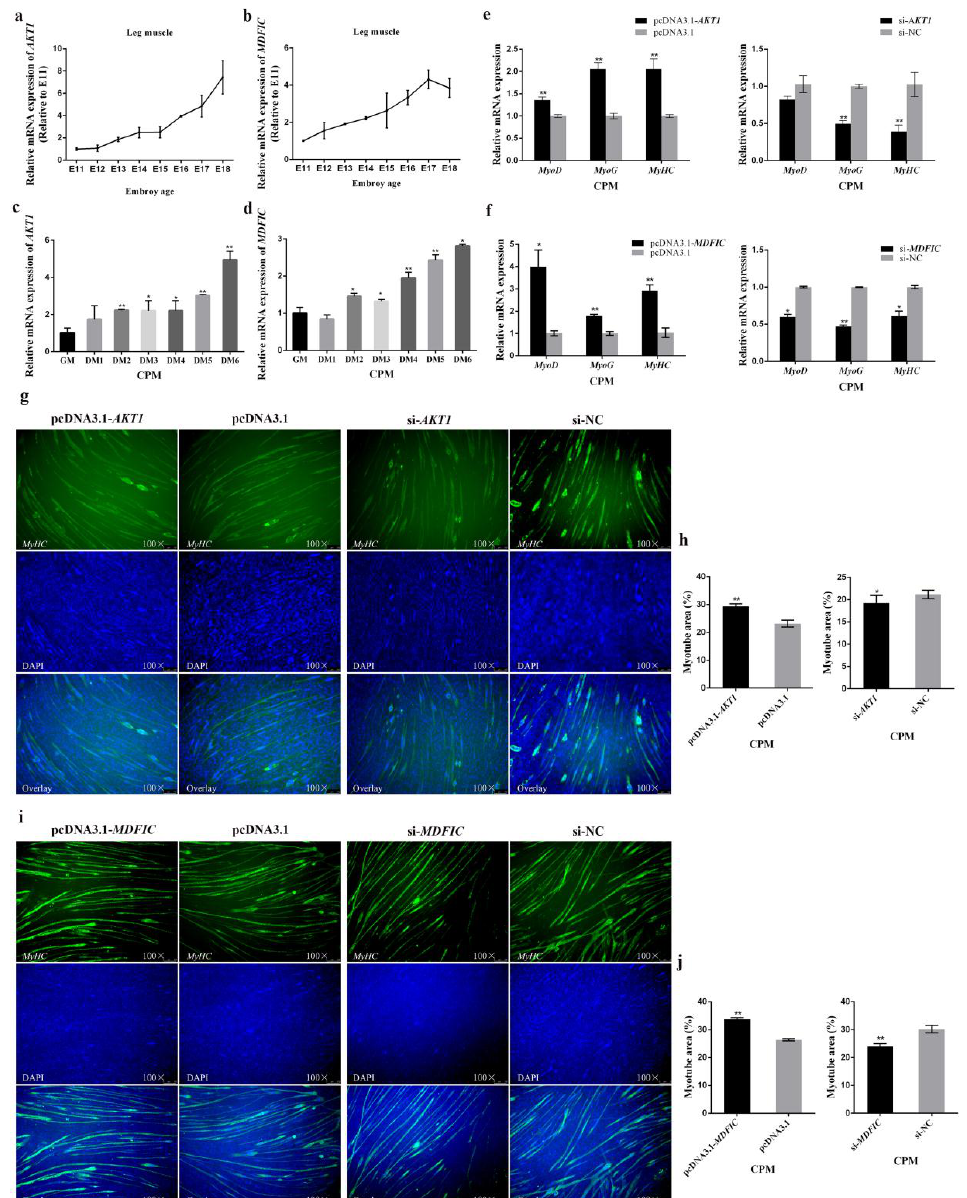
Figure 6. Both AKT1 and MDFIC promote myoblast differentiation, while suppress myoblast apoptosis. ( a ) Relative expression of AKT1 in Xinghua chicken leg muscle from E11 to E18. ( b ) Relative expression of MDFIC in Xinghua chicken leg muscle from E11 to E18. ( c ) Relative mRNA expression of AKT1 during CPMs induced differentiation. ( d ) Relative mRNA expression of MDFIC during CPMs-induced differentiation. ( e , f ) Relative mRNA expression of the cell differentiation-related genes after overexpression or inhibition of AKT1 or MDFIC in CPMs. ( g , i ) Immunofluorescence of MyHC after overexpression or knockdown of AKT1 and MDFIC in CPMs. ( h , j ) Comparison of the area of myotubes described in ( g , i ). Results of all groups are shown as mean ± S.E.M. of three independent assessment methods. Statistical significance of the mean difference was assessed using unpaired two-sample t -tests. * p < 0.05; ** p < 0.01. NC, negative control.